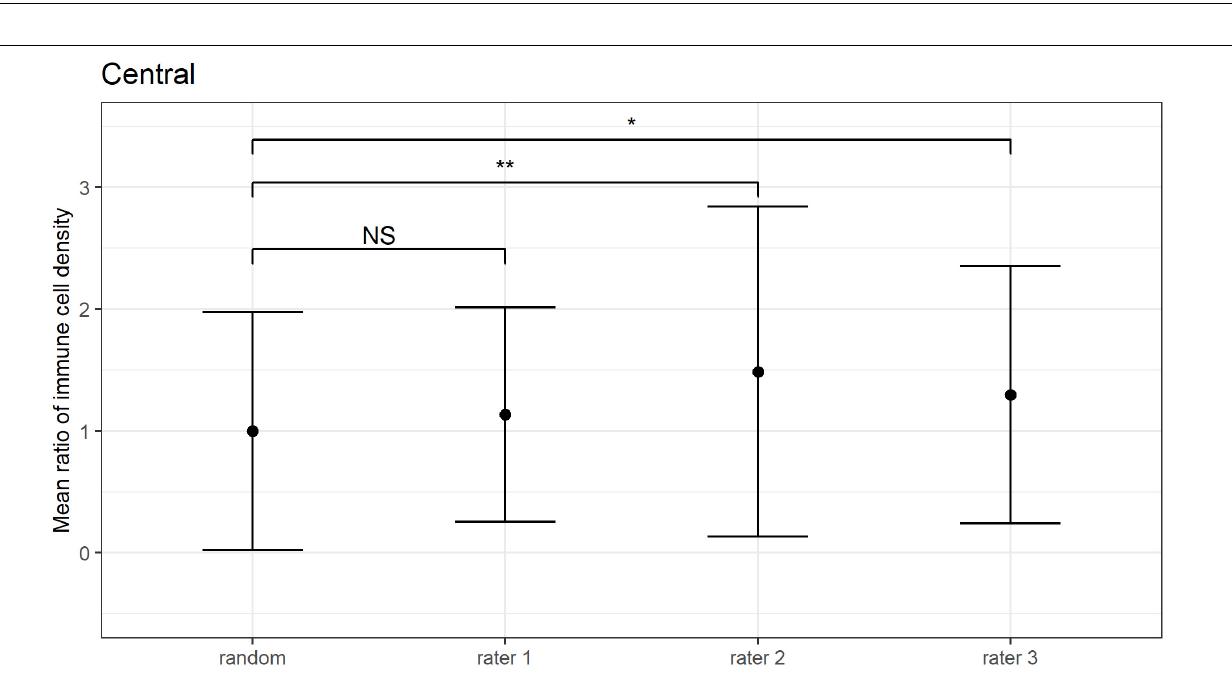
Frontiers in Medicine |